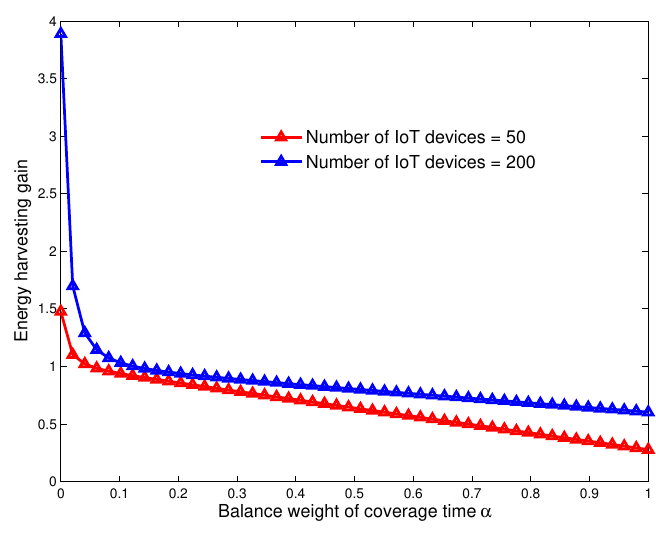
Figure 9. Energy harvesting gain versus α .